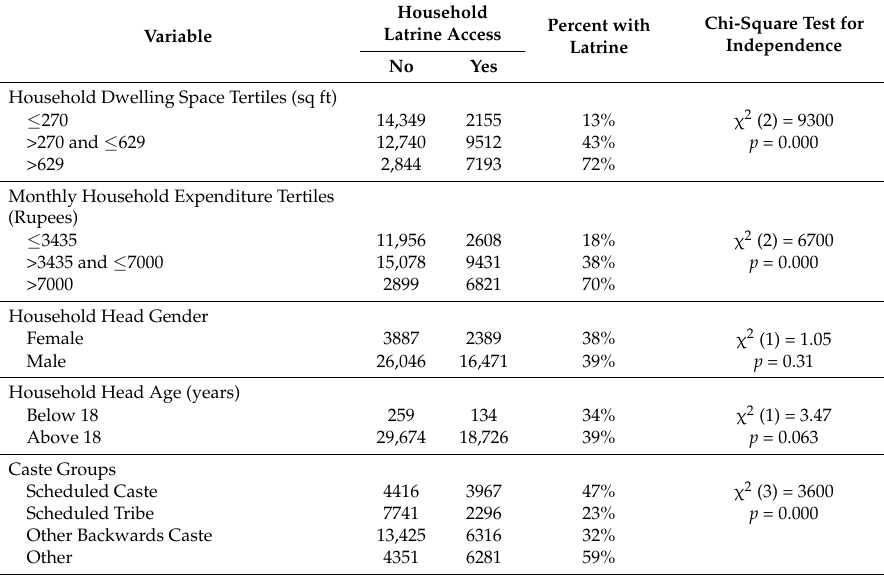
Table 1. Descriptive statistics and chi-square test